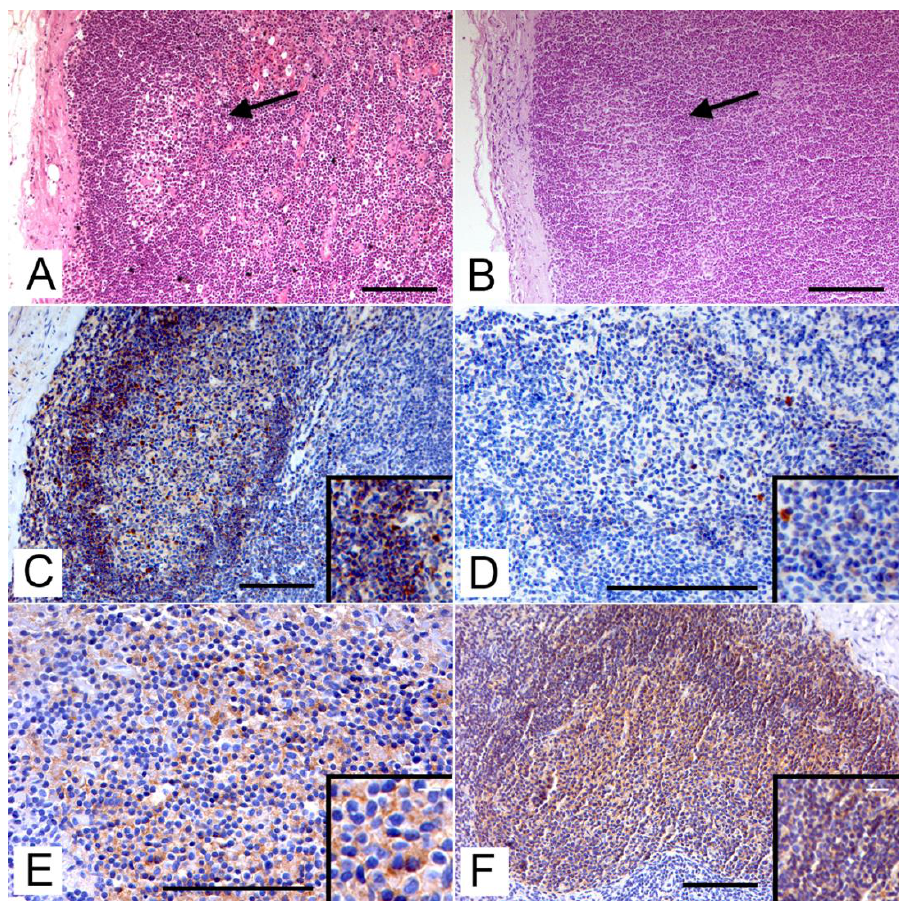
Figure 1. Immunolocalization of B-cells on lymph node tissue cortex with secondary lymphatic follicles by immunohistochemistry (IHC). ( A ) Roe deer. Secondary lymphoid follicle (arrow) in lymph node cortex (H-E, bar = 100 µ m). ( B ) Fallow deer. Secondary lymphoid follicle (arrow) in lymph node cortex (H-E, bar = 100 µ m). ( C ) Roe deer. Immunohistochemical staining with anti-CD79a (Exbio) antibody in lymphatic cells within the follicle (IHC, bar = 100 µ m). Inset: CD79a-positive B lymphocytes in the mantle zone (IHC; bar = 25 μm). ( D ) Fallow deer. Slight immunohistochemical staining with anti-CD79a (Novusbio) antibody in the mantle area (IHC, bar = 100 µ m). Inset: CD79a- positive B lymphocytes in the mantle zone (IHC; bar = 20 μm). ( E ) Roe deer. Immunohistochemical staining with anti-CD20 antibody (IHC, bar = 100 m). Inset: CD20-positive B lymphocytes in the germinal center (IHC; bar = 10 μm). ( F ) Fallow deer. Immunohistochemical staining with anti-CD20 antibody (IHC, bar = 100 µ m). Inset: CD20-positive B lymphocytes in the germinal center (IHC; bar = 25 μm).